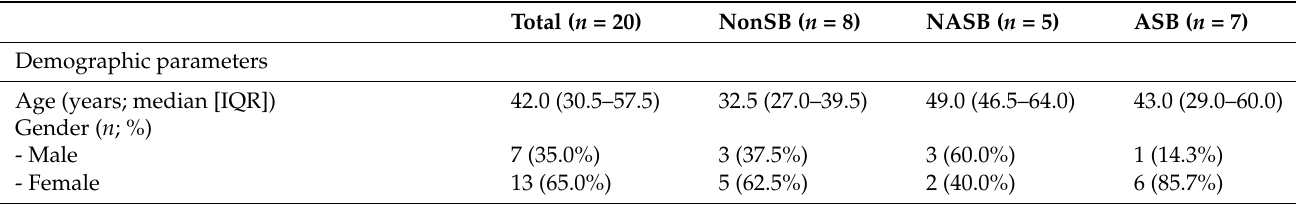
Table 1. The descriptive statistics of listeners’ demographic parameters, perceived annoyance, and heart rate-related parameters.